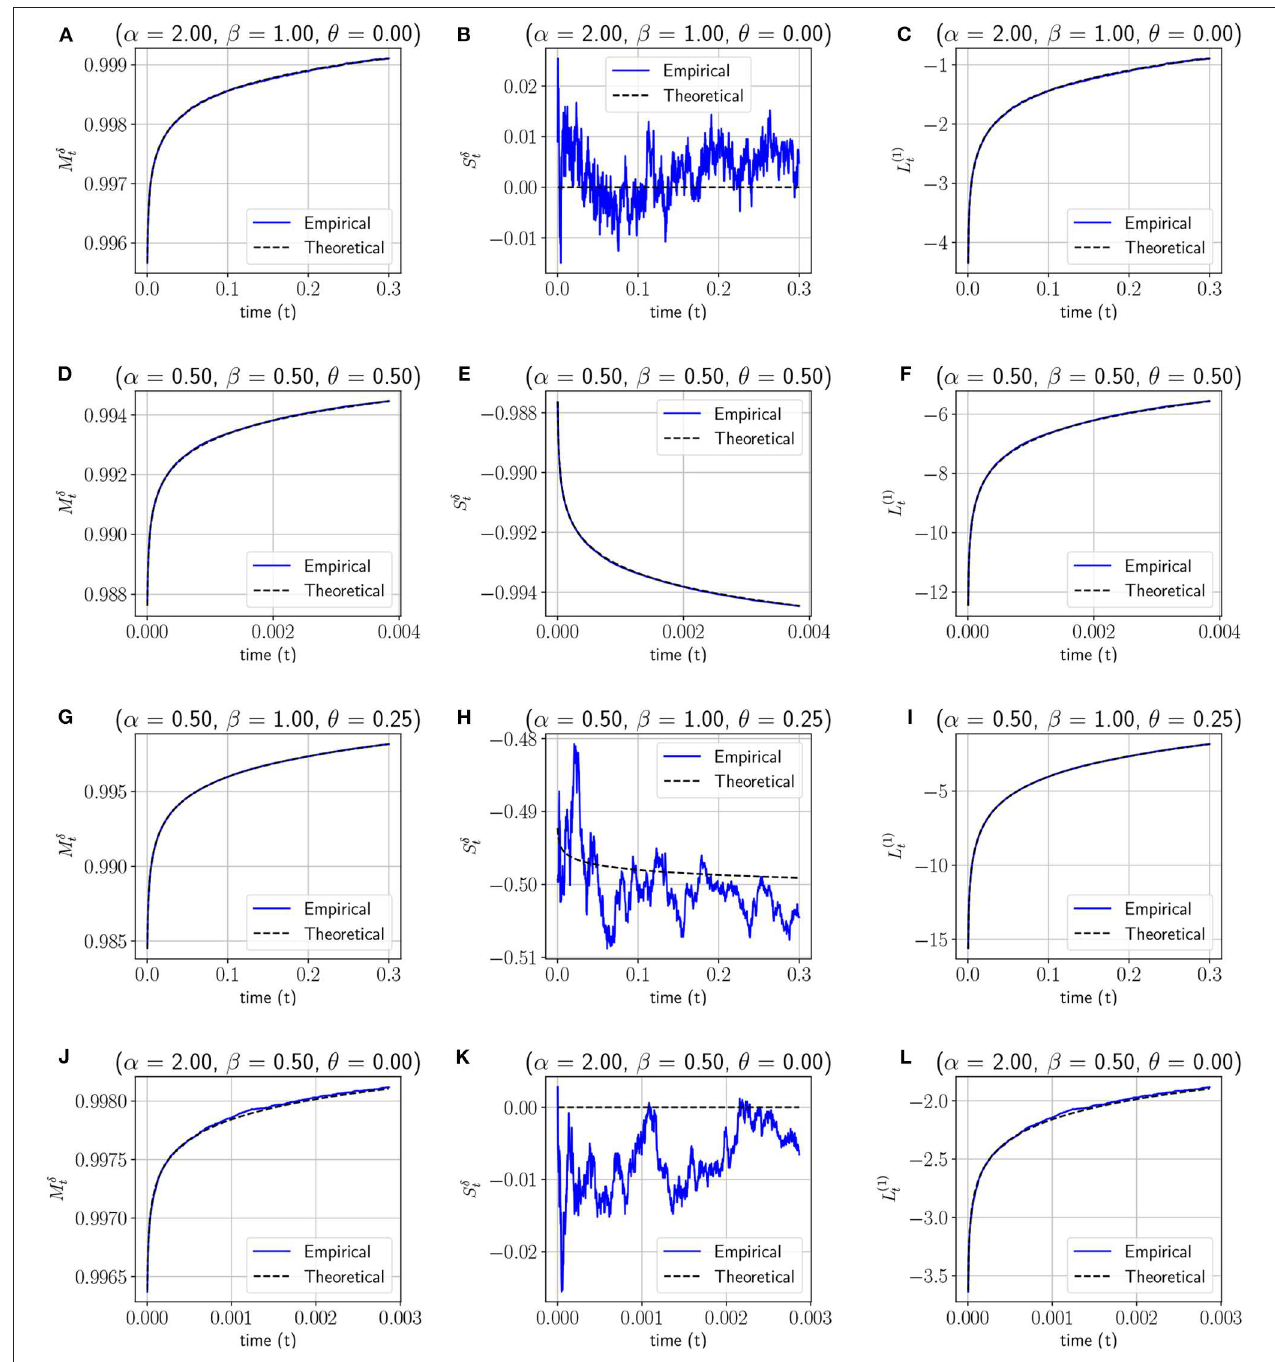
FIGURE 2 | The time-dependent theoretical and empirical absolute moments and signed absolute moments of order δ empirical expected log absolute for the following four types of diffusion models: (A–C) Normal diffusion equation, (D–F) Neutral diffusion equation, (G–I) Space fractional diffusion equation, (J–L) Time fractional diffusion